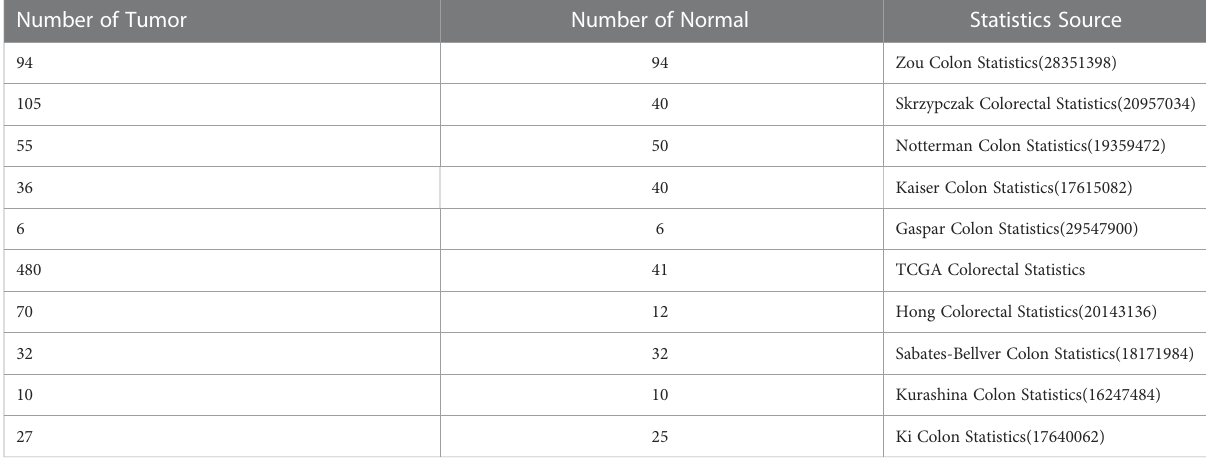
TABLE 2 Statistics Source and the characteristics of the samples (Oncomine